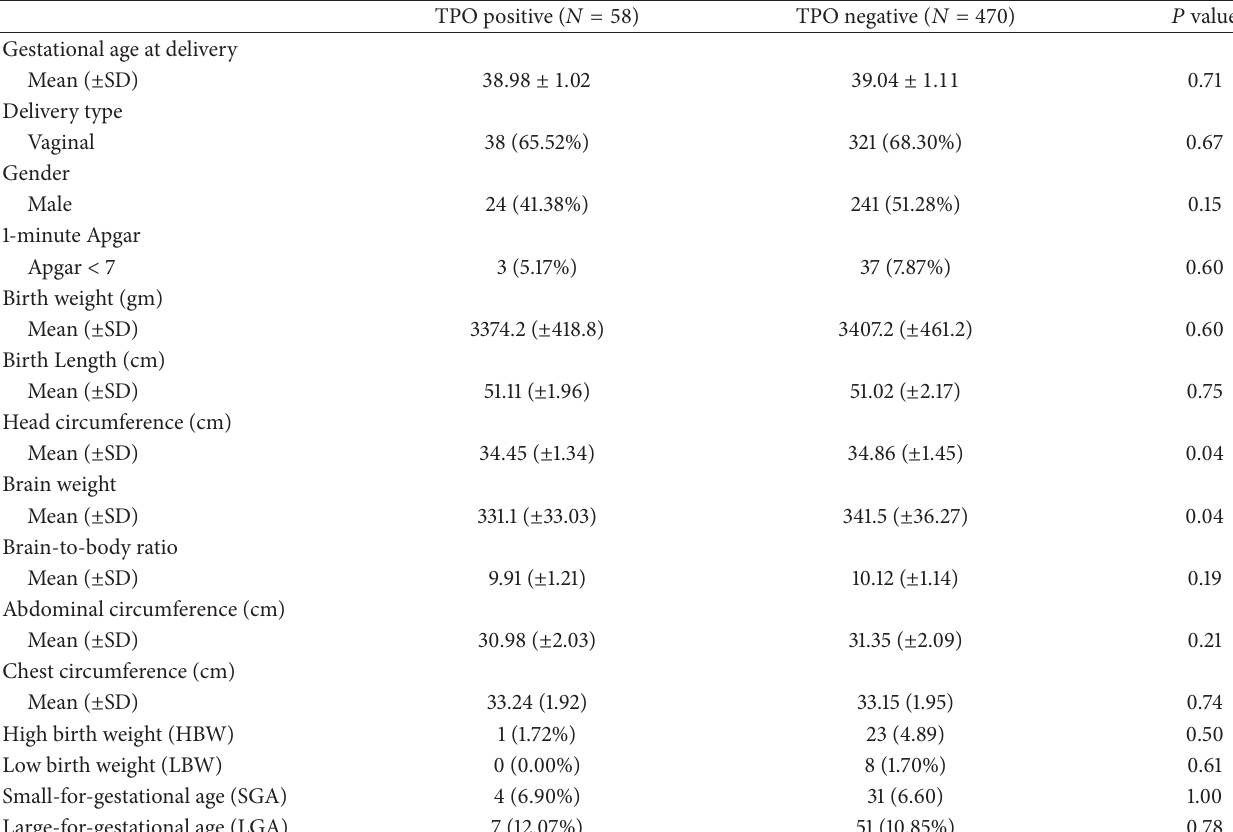
Table 2: Selected infant characteristics at delivery by maternal TPO